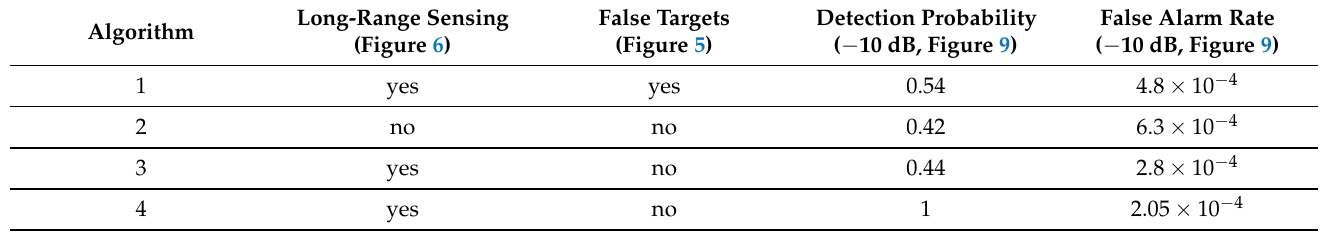
Table 2. Comparisons among different